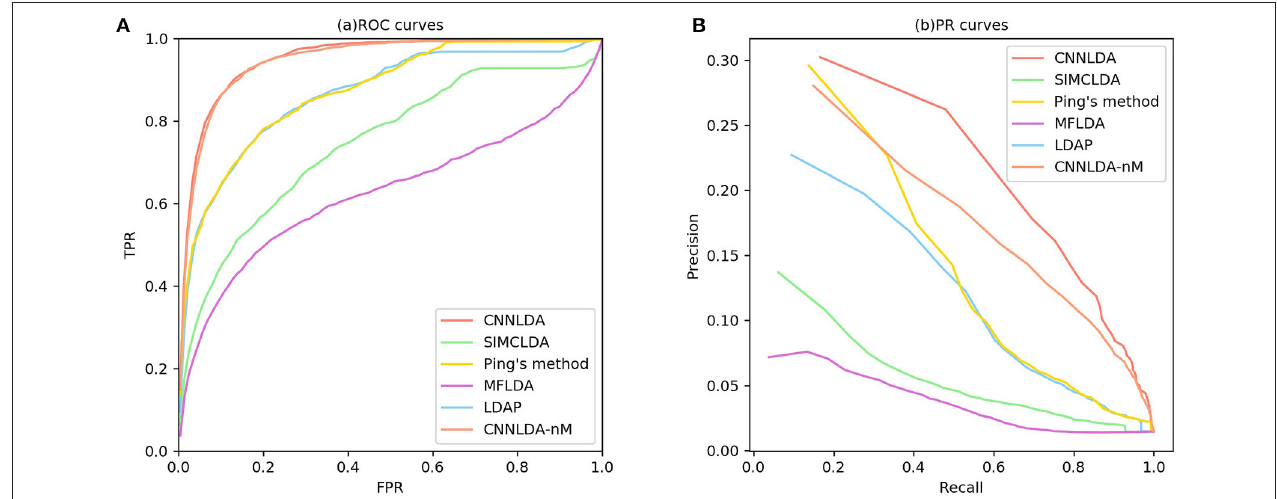
FIGURE 3 | ROC curves and PR curves of CNNLDA and other methods for all the diseases. (A) ROC curves of all the methods. (B) PR curves of all the methods. TABLE 1 | AUCs of ROC curves of CNNLDA and other methods for all of the diseases and 10 well-characterized diseases. Disease